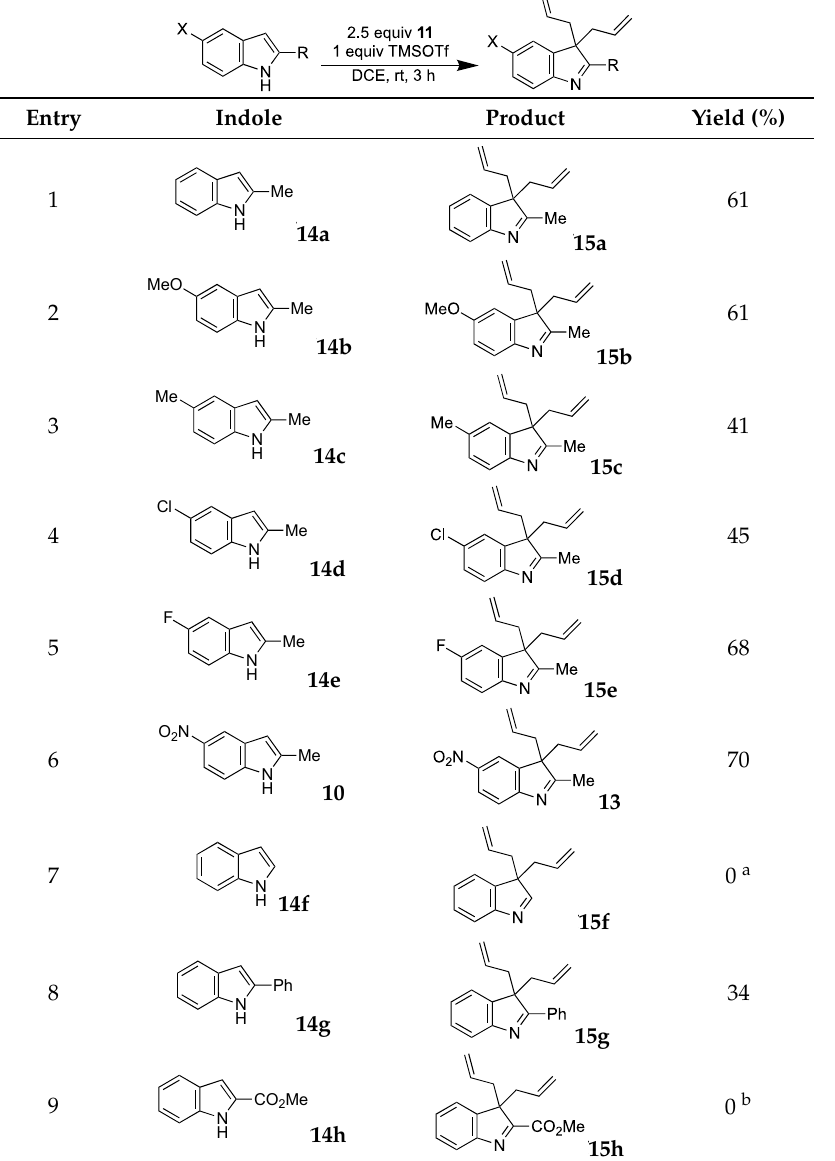
Table 2. C3-Dialkylation of functionalized indoles with allyl imidate.